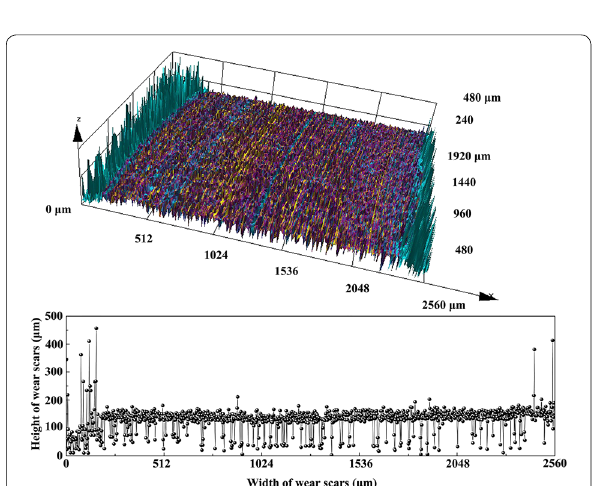
Figure 16 3-D profiles and height variations of wear scars on the 316L